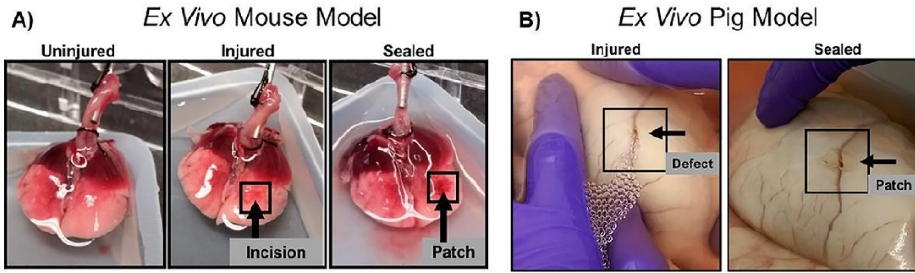
Figure 3. Sealing activity of hydrogel patches studied in ex vivo lung lesions in mouse or pig models . The first evaluation of patch adherence and efficacy to close the defect was realized on ex vivo models of mouse lungs ( A ) and pig lungs ( B ). Arrows indicate the place of the defect and the position of the patch. The model consists of lungs inflated and immersed in phosphate-buffered saline (PBS) useful to identify the air leak and the seal after patch application. (Reprinted with permission from Ref. [45]. Copyright 2021 Elsevier.)